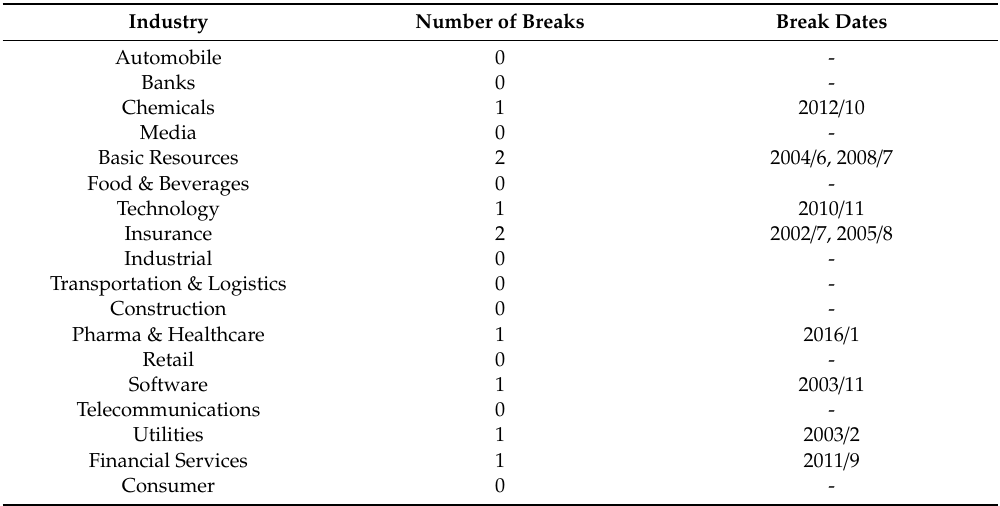
Table 6. Testing for structural change—the single factor models with HAC covariances. Industry Number of Breaks Break Dates Automobile 0 - Banks 0 - Chemicals 1 2012 / 10 Media 0 - Basic Resources 2 Food & Beverages 0 -